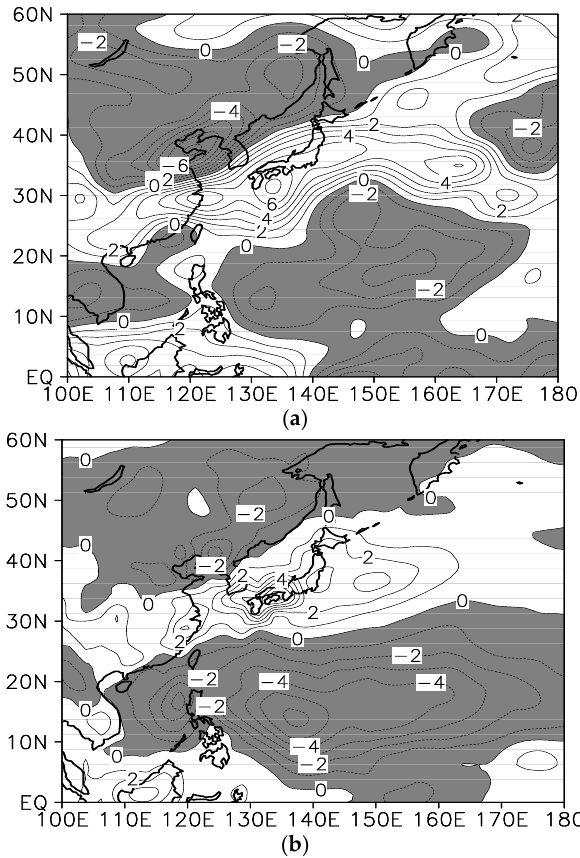
Figure 2. Differences in ( a ) precipitable water and ( b ) precipitation between 2014 and climatological mean in August. Contour intervals are 1 kg·m −2 and 1 mm·day −1 . Shaded areas denote negative values.